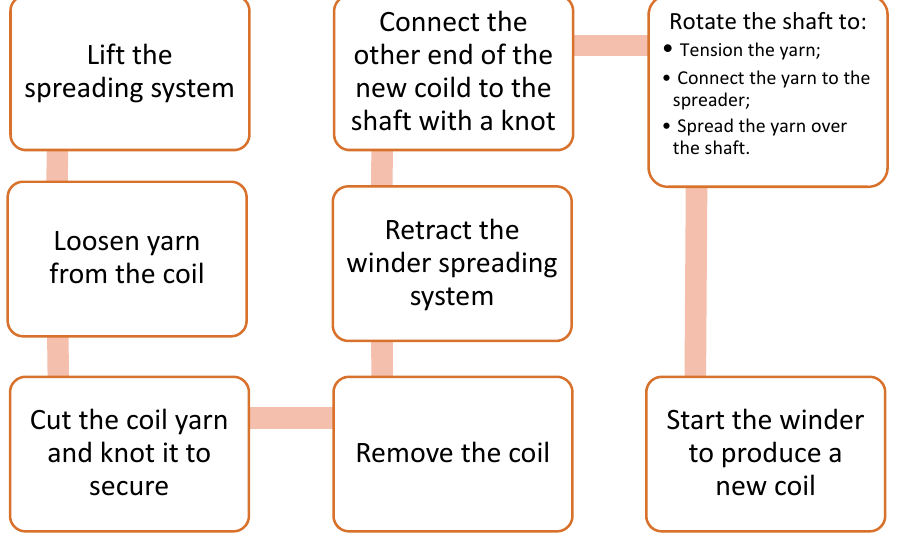
Figure 1. Manual process for obtaining a yarn